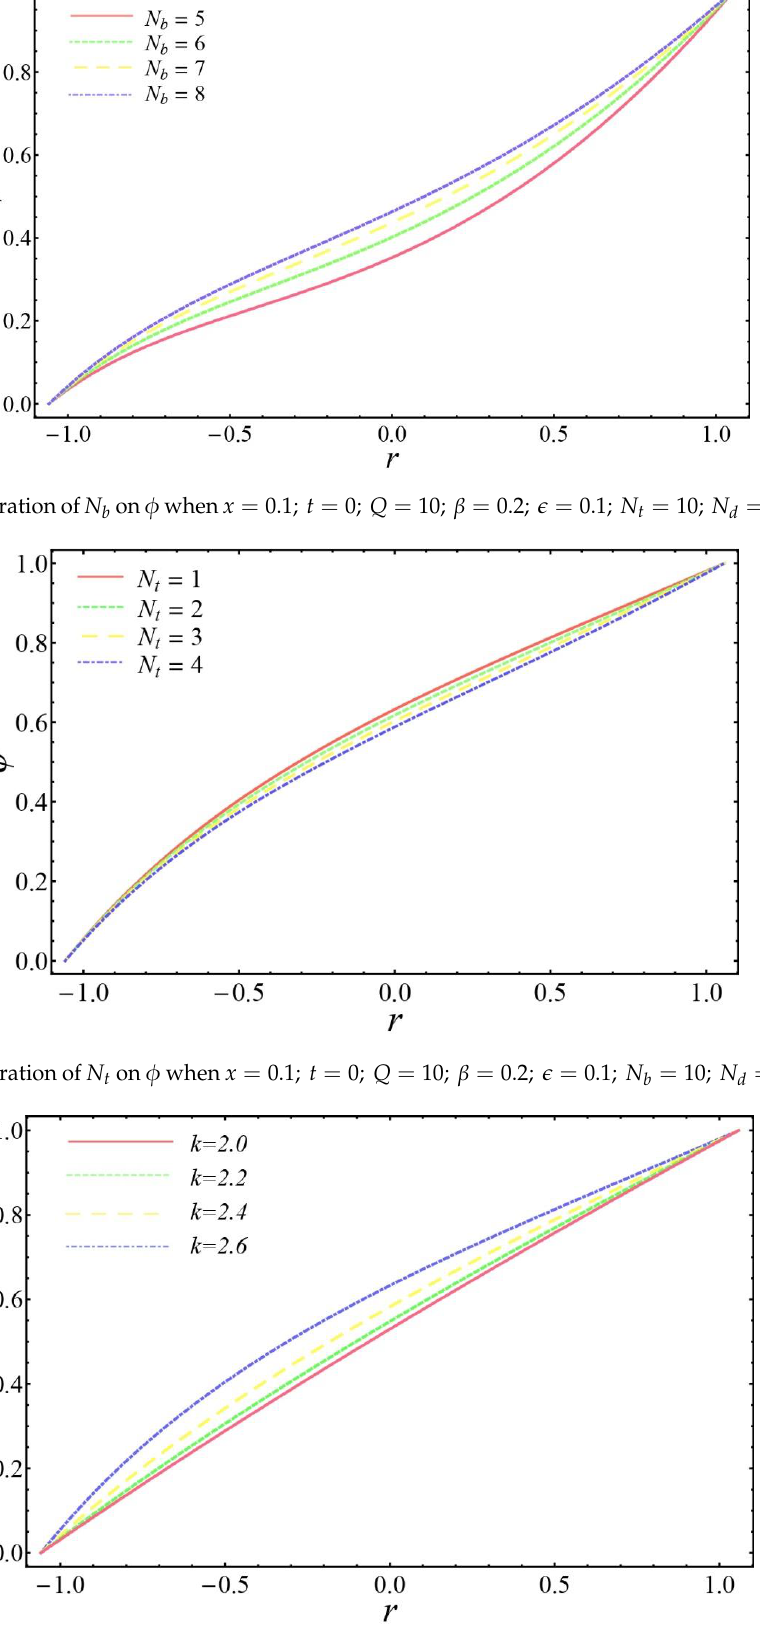
Figure 11. Alteration of 𝐿 𝑑 on γ when 𝑥 = 0.1; 𝑡 = 0; 𝑄 = 10; 𝛽 = 0.2; 𝜖 = 0.1; 𝑁 𝑏 = 2; 𝑁 𝑑 = 1; 𝑘 = 1.5.